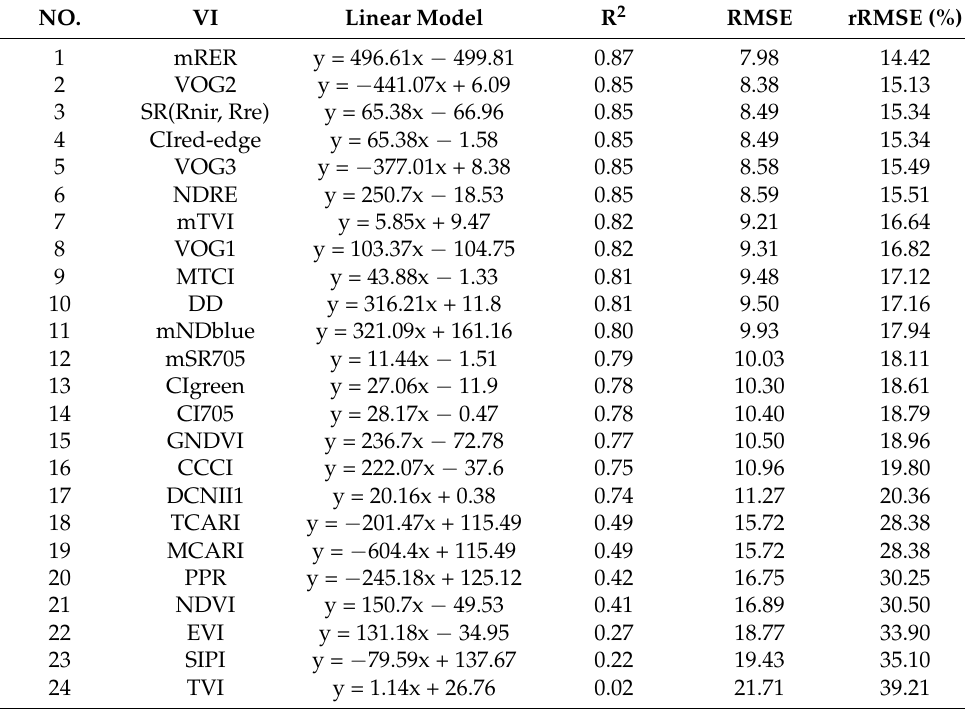
Table 3. Verification of vegetation index (VI) sensitivity to leaf chlorophyll content (LCC). NO.